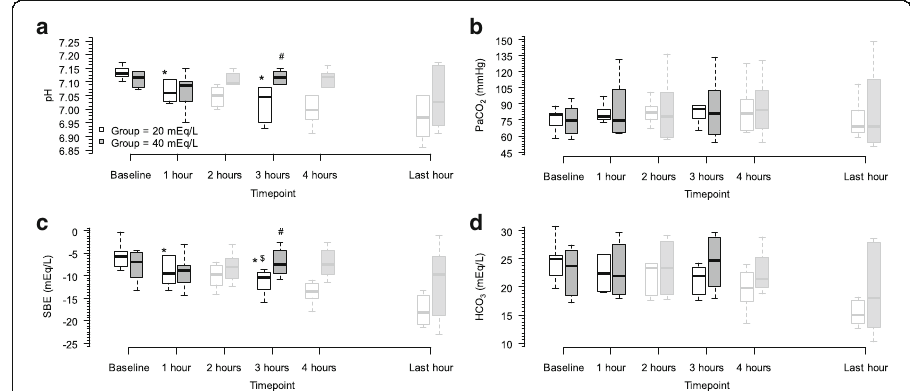
Fig. 1 Temporal acid-base variation based on group. Panel a shows the pH changes over time (mixed model: group vs. pH interaction, P = 0.089; timepoint vs. pH interaction, P < 0.001; timepoint vs. group interaction, P = 0.003). Panel b shows the PaCO P =0.913; 2 changes over time (mixed model: group vs. PaCO 2 interaction, timepoint vs. PaCO 2 interaction, P =0.311; timepoint vs. group interaction, P =0.899). Panel c shows the SBE evolution over time (mixed model: group vs. SBE interaction, P =0.02; timepoint vs. SBE interaction, P <0.001, timepoint vs. group interaction, P <0.001). Panel d shows the HCO 3 changes over time (mixed model: group vs. HCO 3 interaction, P = 0.401; timepoint vs. HCO 3 , P = 0.607; timepoint vs. group interaction, P = 0.664). SBE denotes standard base excess. Light gray boxplots were not used in analysis. *Wilcoxon post hoc analysis, P < 0.05 vs. baseline. #Mann-Whitney post hoc analysis, variable variation from baseline to 3 h; P < 0.05 vs. group 40. $Mann-Whitney post hoc analysis, P < 0.05 vs. group 40